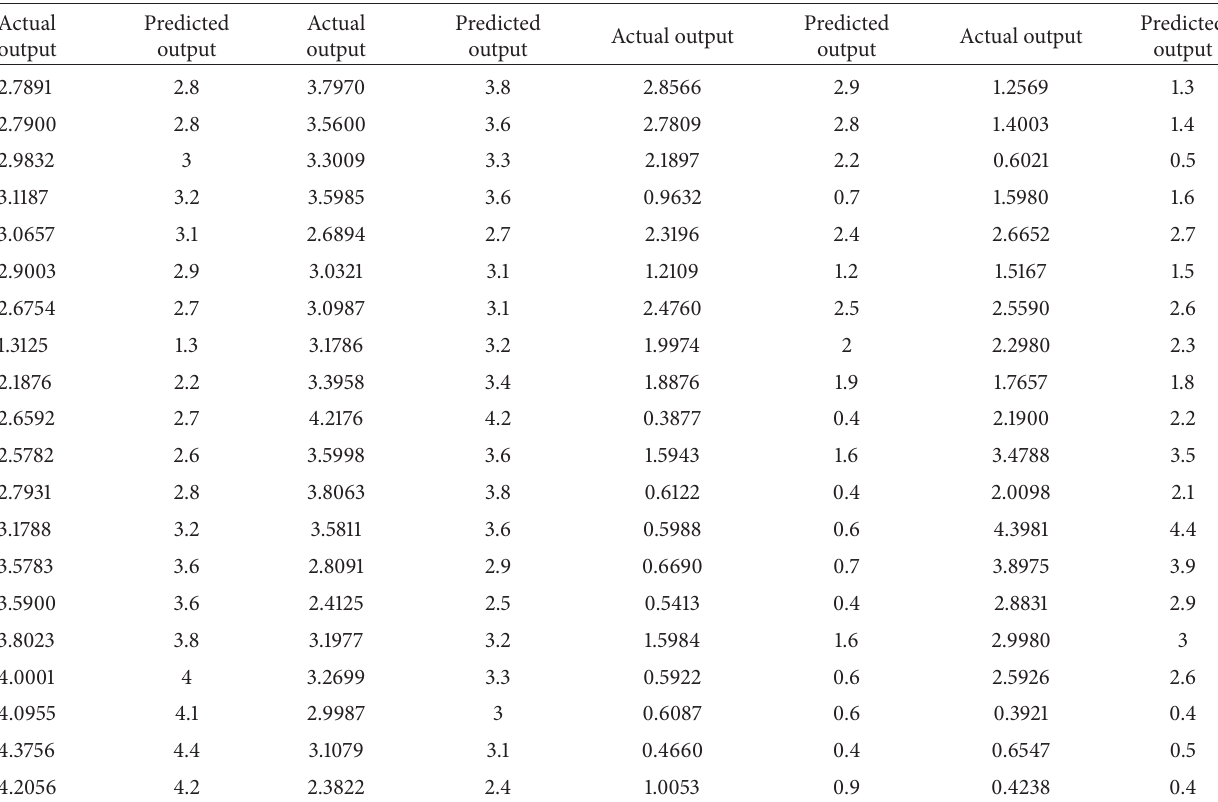
Table 6: Actual and predicted output of the proposed ensemble NN